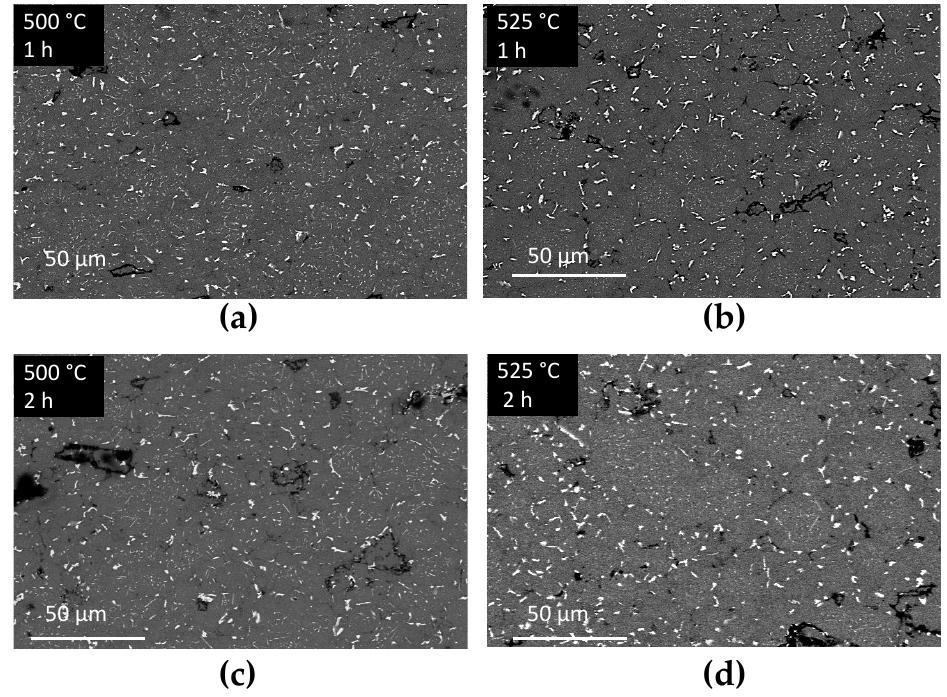
Figure 12. SEM images (BSE mode) taken at a 1200 × magnification of heat-treated compacts at: ( a ) 500 ◦ C, 1 h; ( b ) 525 ◦ C, 1 h; ( c ) 500 ◦ C, 2 h; ( d ) 525 ◦ C, 2 h.